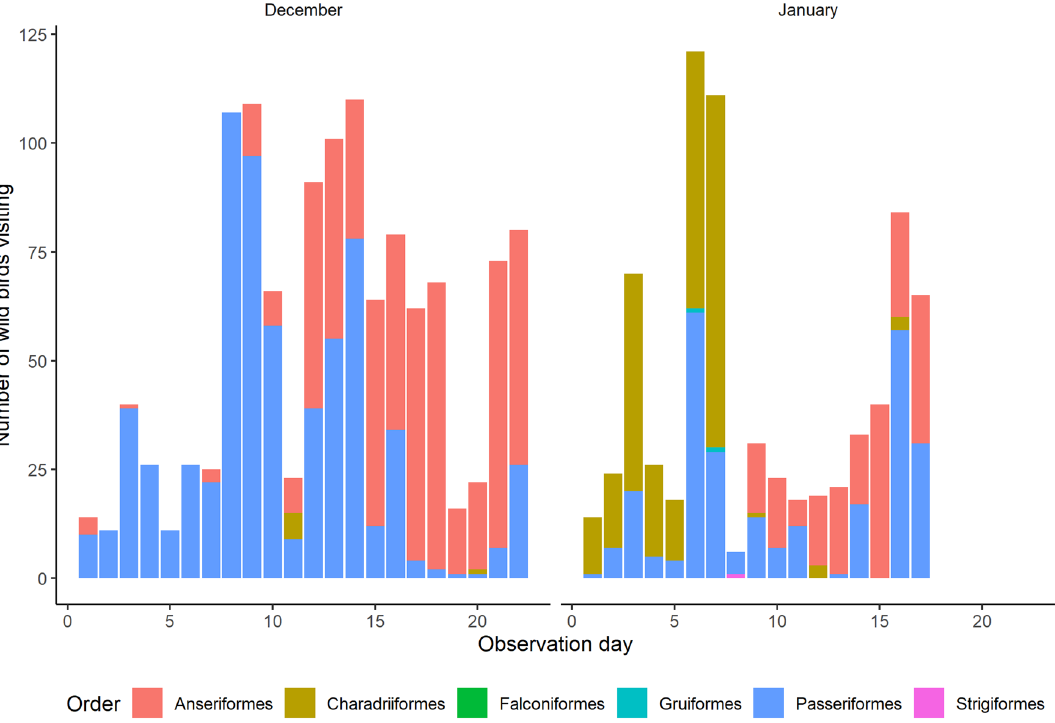
Figure 4. Number of wild birds visiting the free-range study area by observation day and wild bird Order in the months December and January during a previous study at the same study farm (Elbers & Gonzales,